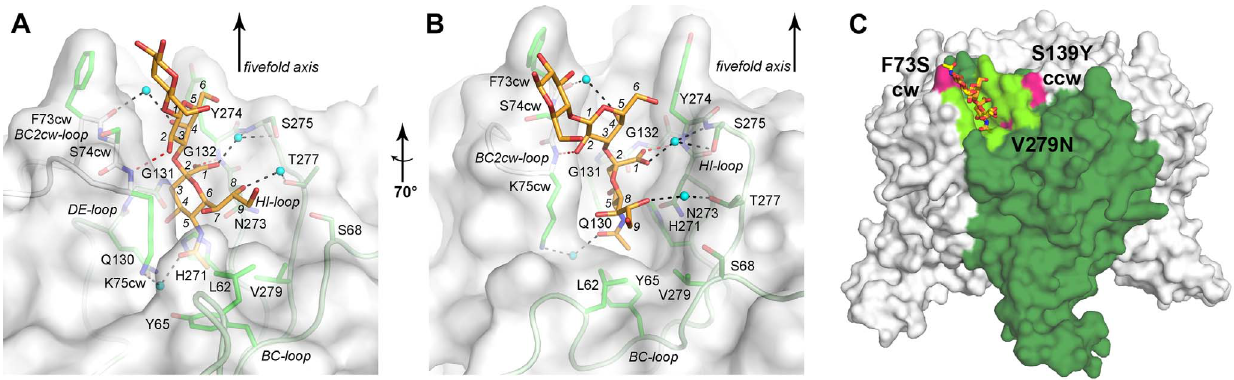
Figure 3. Specific interactions of LPyV VP1 and 3SL. A and B. LPyV VP1 is shown in cartoon and surface representation, with side chains interacting with 3SL shown in stick representation. The 3SL oligosaccharide is shown in stick representation and colored by element, with carbons in orange, nitrogens in blue and oxygens in red. Waters are represented with spheres. Selected carbon atoms of 3SL are numbered in italics. Residues engaging in hydrophobic interactions with 3SL are colored bright green and residues forming polar van der Waals contacts or water-mediated hydrogen bonds are colored dark green. Direct hydrogen bonds between LPyV VP1 and the oligosaccharide are shown as red dashed lines, water- mediated hydrogen bonds are colored black. The views depicted in A and B differ by a 70 u rotation around a vertical axis. C. Location of LPyV VP1 mutations influencing cell tropism. An entire LPyV VP1 pentamer is shown in surface representation. The N-terminal arms were omitted for clarity. One monomer is colored dark green, and the residues forming the oligosaccharide binding site are highlighted in light green. Residues whose mutation was shown to influence cell tropism of LPyV VP1 are colored magenta. The 3SL and 3SLN oligosaccharides are shown in stick representation and colored orange and yellow,